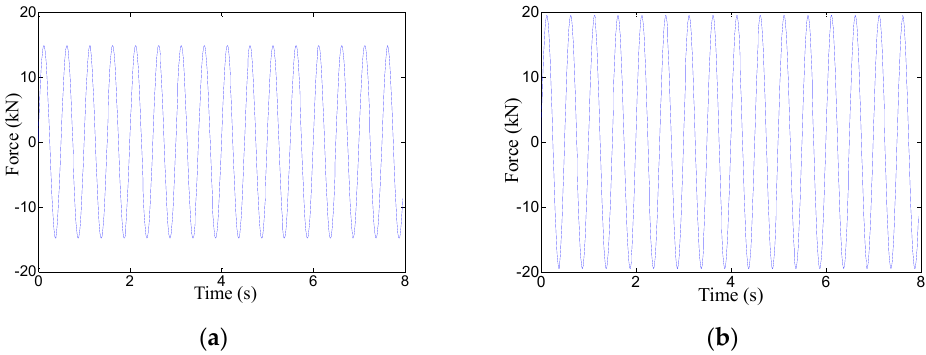
Figure 23. ( a ) The time-domain results of H1-1 before correction; ( b ) The time-domain results of H1-1 after correction Table 6. Experimental scheme of harmonic force and the comparisons of F m , F c and F a .